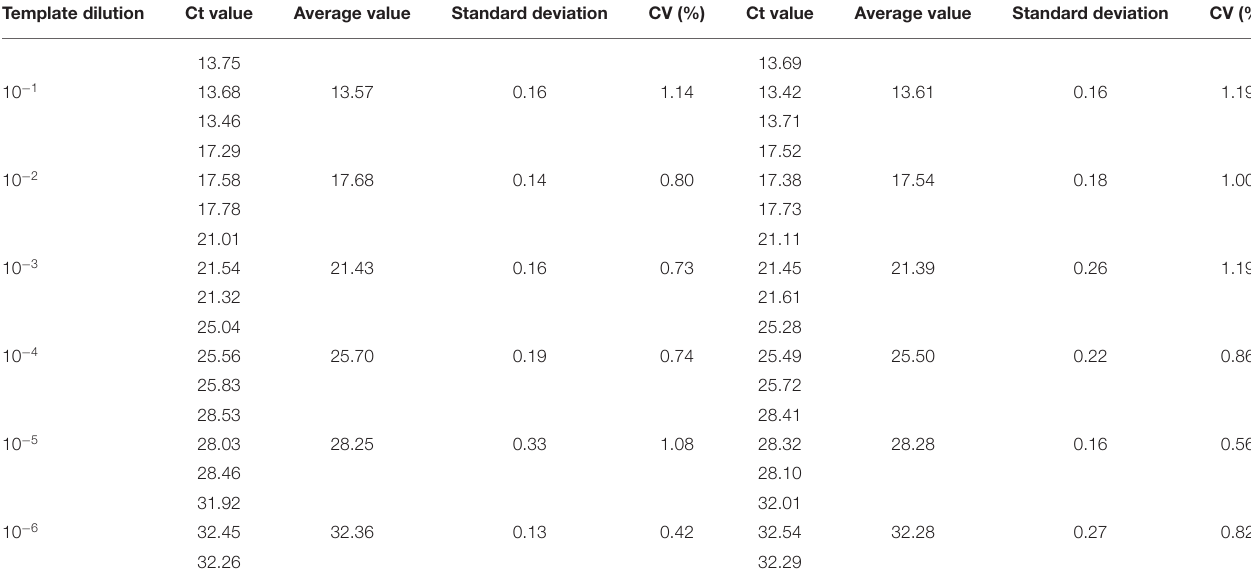
TABLE 4 | Intra-reproducibility and intra-repeatability of E183L gene by dual real-time PCR/. Template